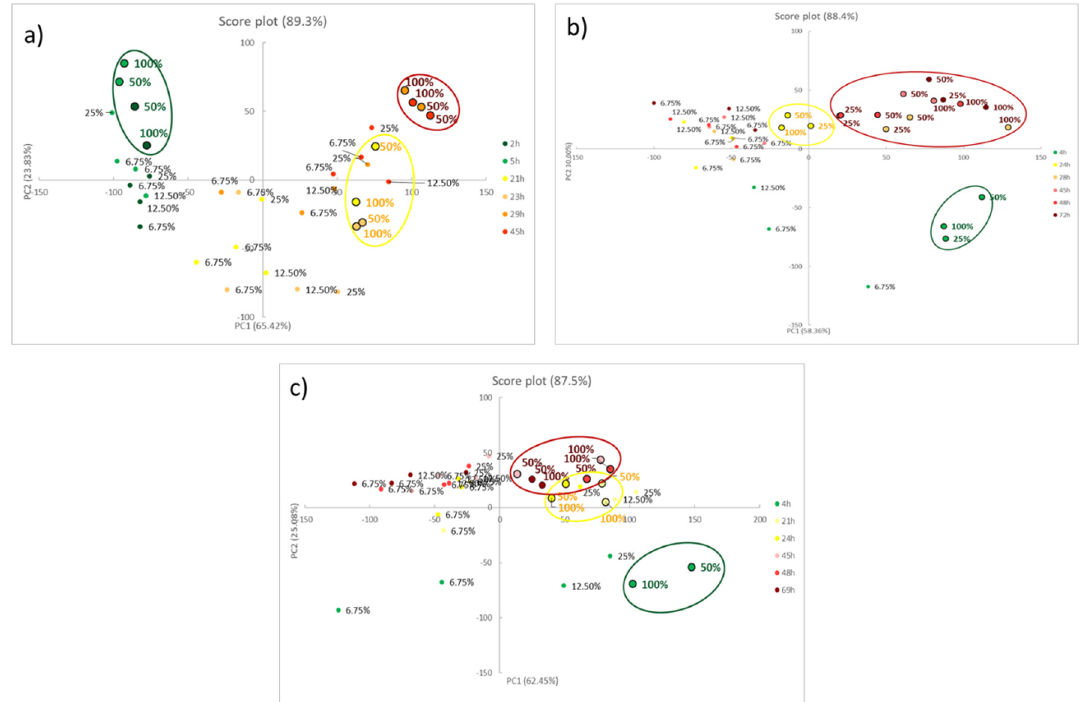
Figure 5. The score plot of the PCA models on the first two principal components, considering samples for sensibility tests of chicken meat ( a ), beef meat ( b ) and pork meat ( c ). The trays with similar mass to training and test samples, i.e., 100%, were considered the